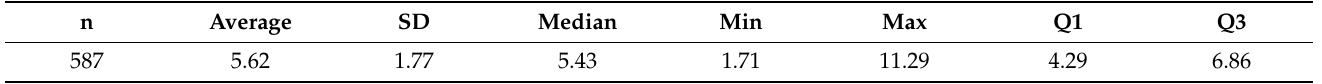
Table 6. Sedentary time in the study group.